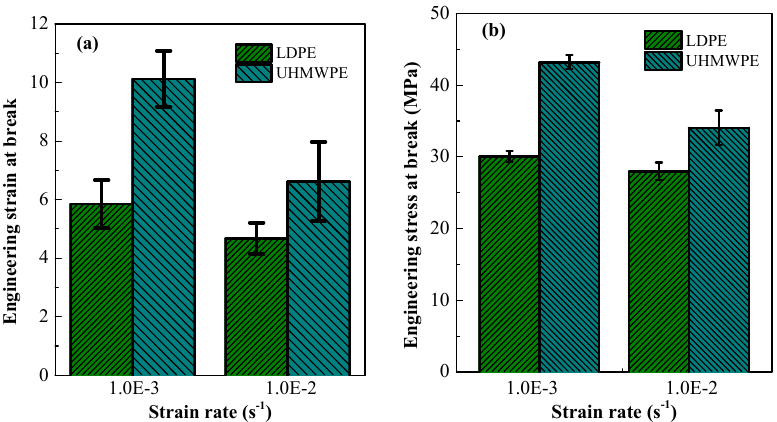
Figure 10. Contrasting engineering ( a ) strain and ( b ) stress at fracture of LDPE and UHMWPE at strain-rate 0.001 and 0.01 s − 1 .